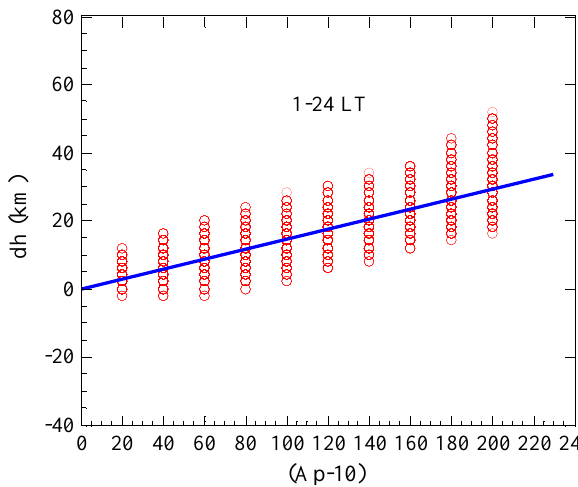
Fig. 10. Mass plot of the differences d h (open circles) between the Figure 10. Mass plot of the differences d h (open circles) between the calculated LTH at certain calculated LTH at certain A p and at A p =10 for various seasons and Ap and at Ap=10 for various seasons and all local times (1-24 LT) as a function of magnetic all local times (1–24LT) as a function of magnetic activity. The solid line is the results of a linear activity. The solid line is the results of a linear regression.